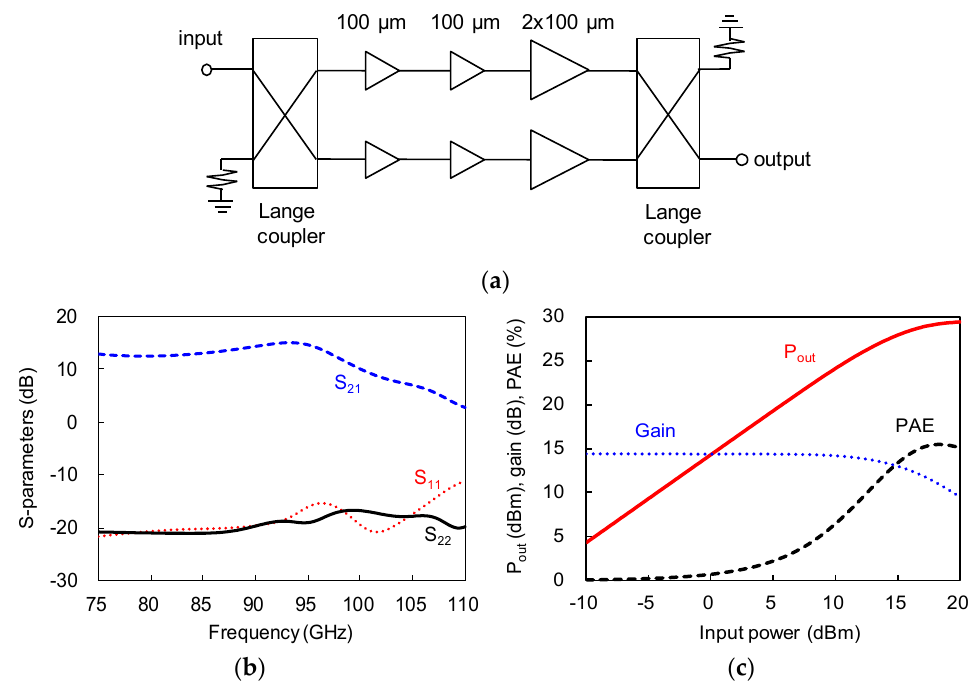
Figure 5. Design of final three-stage power amplifier using Lange couplers. ( a ) Circuit schematic. ( b ) Simulated S-parameters. ( c ) Simulated output power, gain, and PAE as a function of input power at 90 GHz.